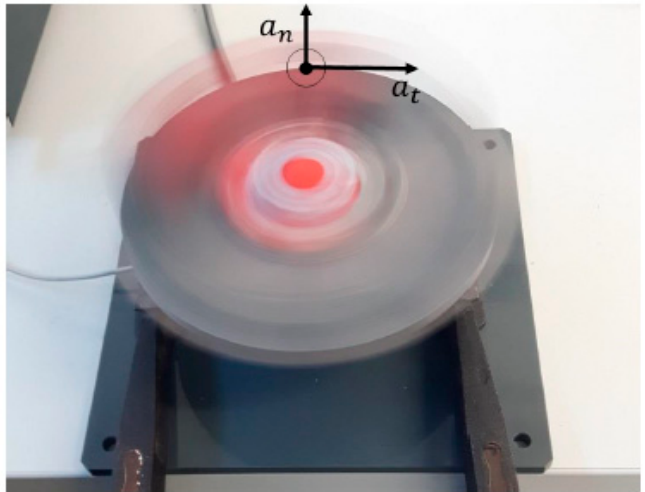
Figure 2. Centrifugal measurement data acquisition .